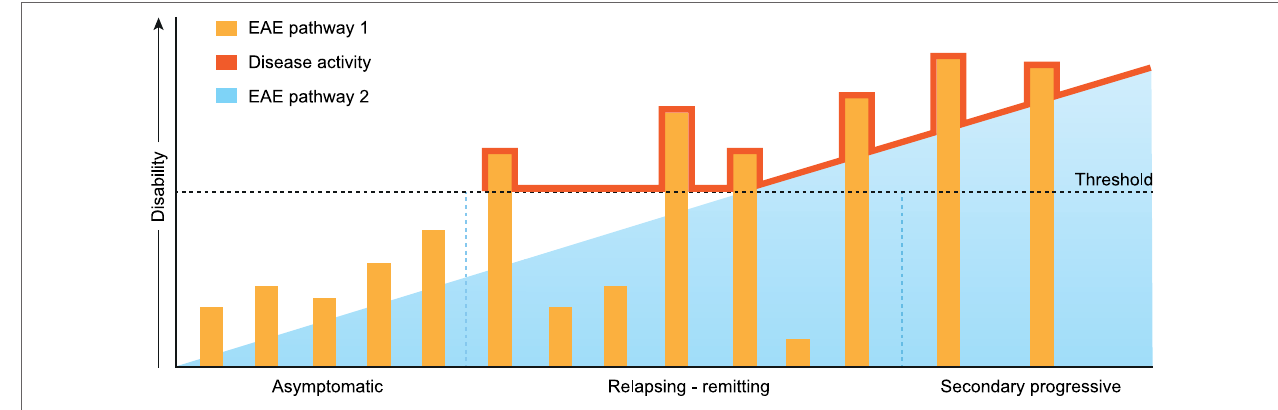
FiGURe 7 | Extrapolation of marmoset experimental autoimmune encephalomyelitis (EAE) pathways 1 and 2 toward multiple sclerosis . The release of myelin antigens from a conceptualized “primary lesion” elicits the activation of distinct EAE mechanisms driven by CD4 + and CD8 + T cells (see Figure 2 ). The activation of CD8 + cytotoxic T lymphocytes by myelin oligodendrocyte glycoprotein processed and presented by Epstein–Barr virus-infected B cells induces progressive demyelination by the killing of oligodendrocytes (EAE pathway 2). It is proposed that the ensuing excessive release of myelin antigens elicits in genetically prone individuals the activation of pro-inflammatory CD4 + T helper 1 (Th1)/Th17 cells which evoke episodic inflammation-based neurological dysfunction (pathway 1). The ensuing clinical symptoms are indicated with the red